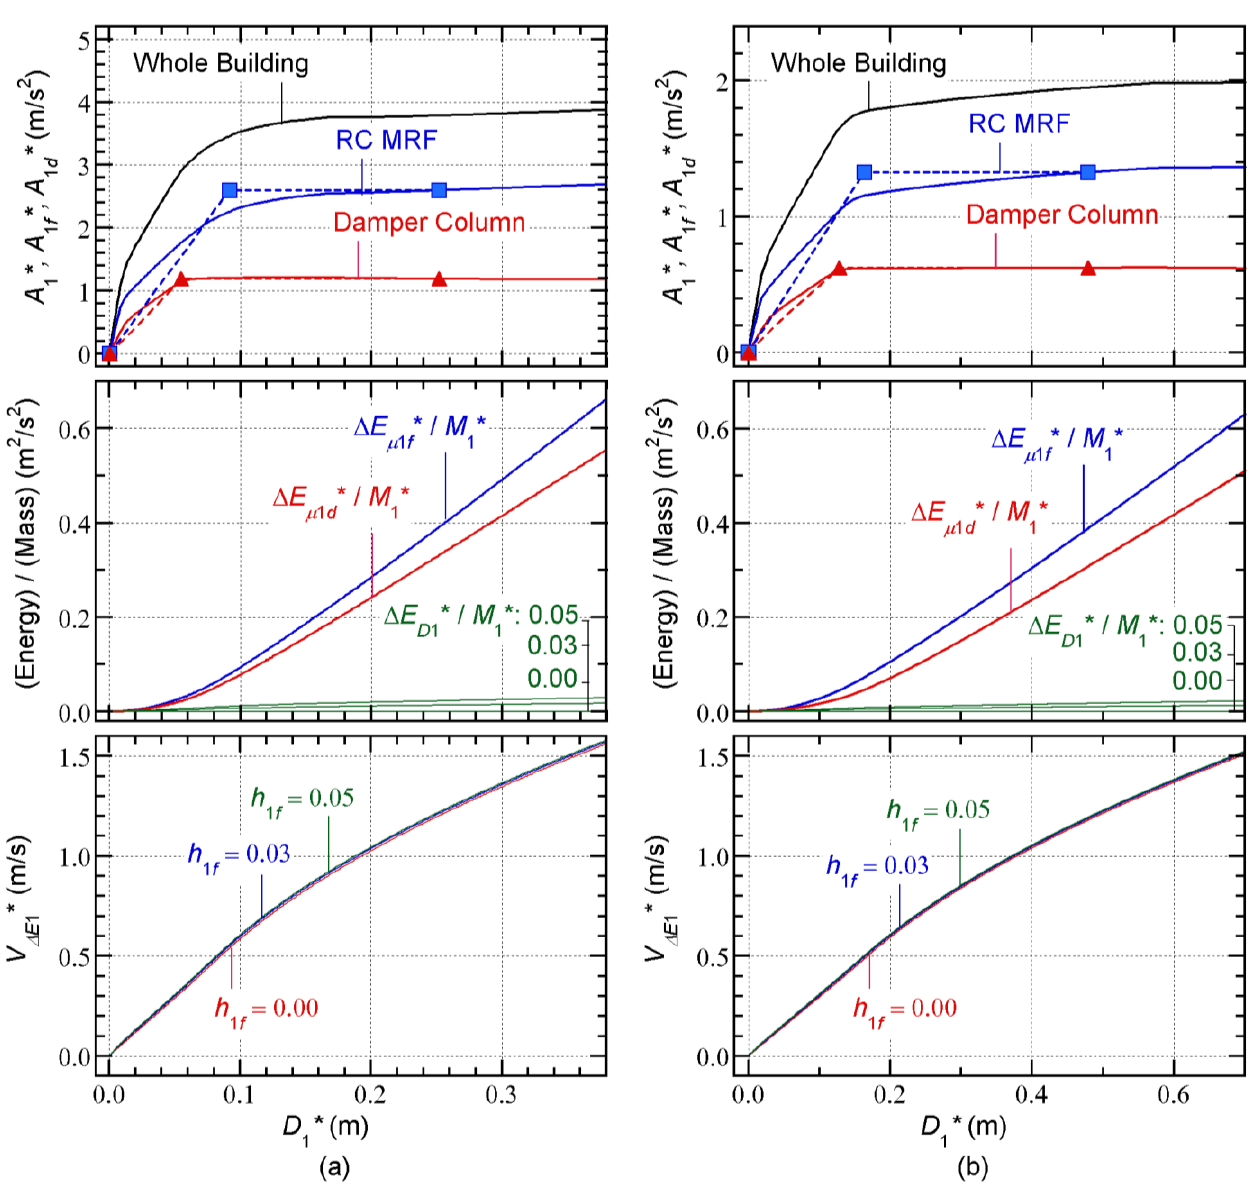
Figure 6. Capacity curves of building models: ( a ) 8-story model; ( b ) 16-story model. The dissipated energy in a half cycle per unit mass of the equivalent SDOF model is calculated according to the procedure described in Section 2.1.2. The calculated results are shown in the middle part of Figure 6. The contribution of the RC MRFs ( calculated using Equations (13) – (15). The contribution from the steel damper columns (